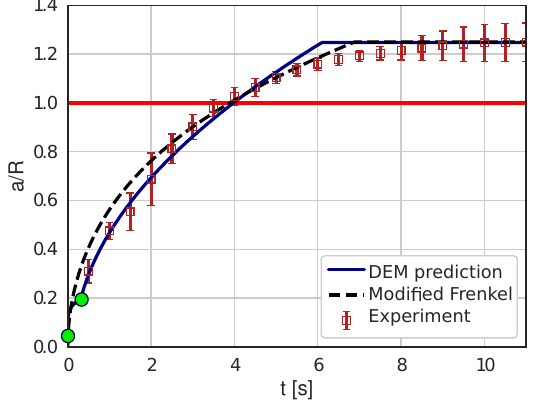
Figure 5. Sintering curve of PA12 particles, R = 31 . 5 µ m com- pared with Frenkel’s model (dashed line), and experimental data (boxes).